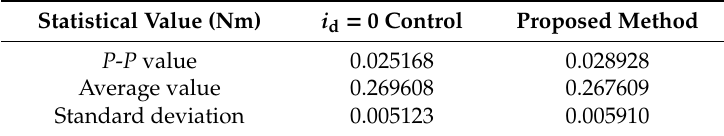
Figure 19. Electromagnetic torque of i d = 0 control. Table 3. Statistics of evaluated